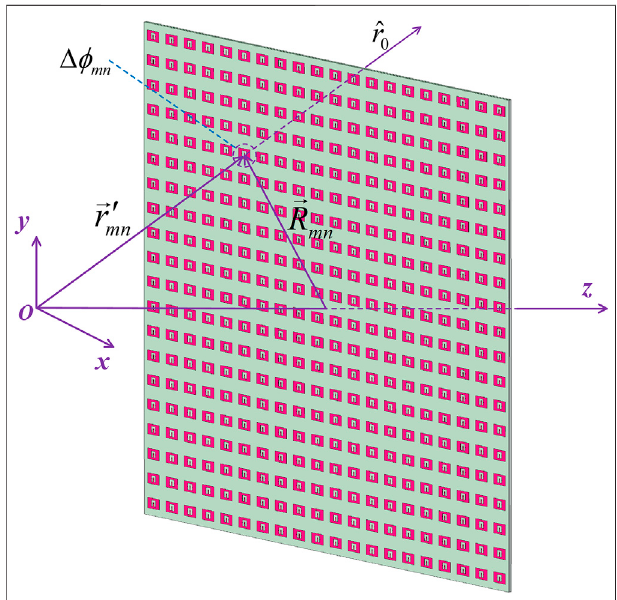
FIGURE 3 | Spatially-fed geometry and the relevant vector